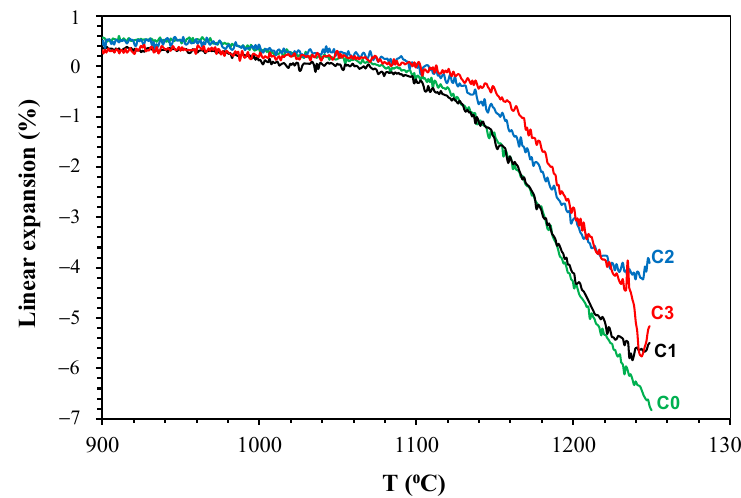
Figure 4. Linear expansion as a function of temperature of the studied compositions.